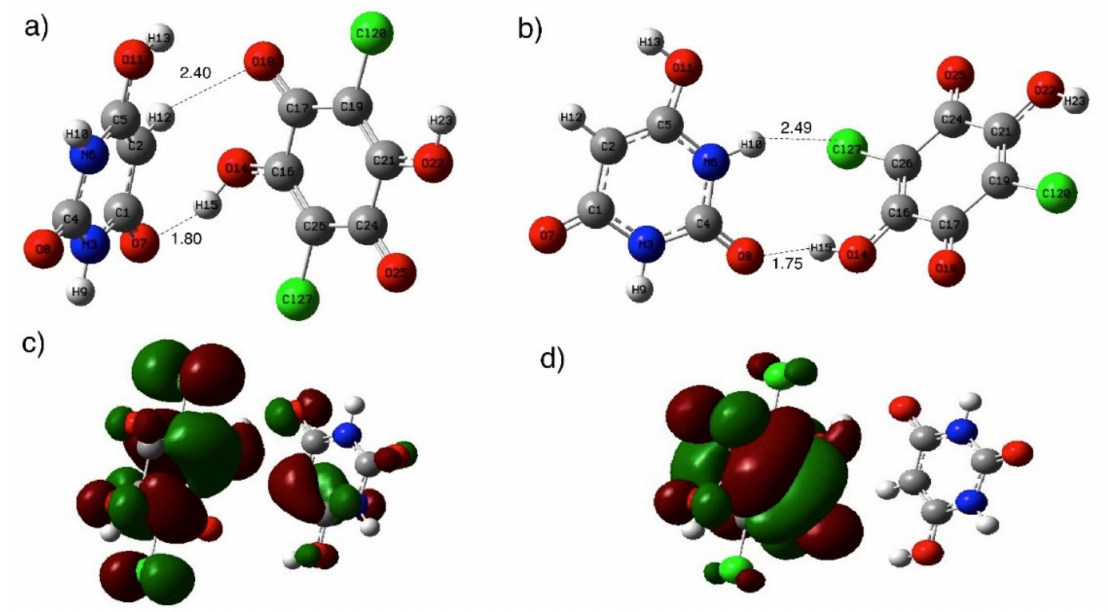
Figure 5. Optimized structure of ( a ) BUChA-I adducts and ( b ) BUChA-II, ( c ) HOMO orbitals and ( d ) LUMO orbitals of BUChA-I in the gas phase calculated at wB97XD/def2-TZVP level of